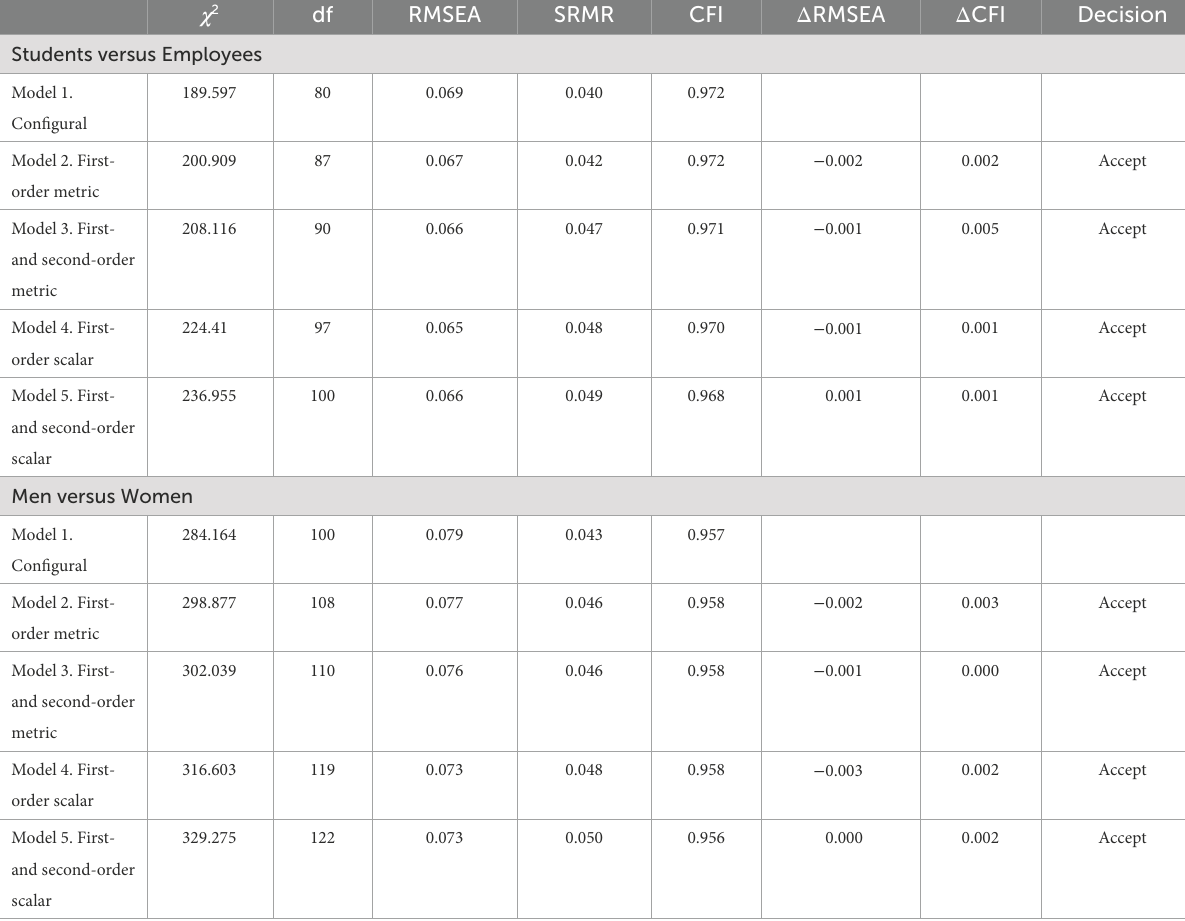
TABLE 3 Fit indices for measurement invariance tests and results of model comparison. χ 2 df RMSEA SRMR